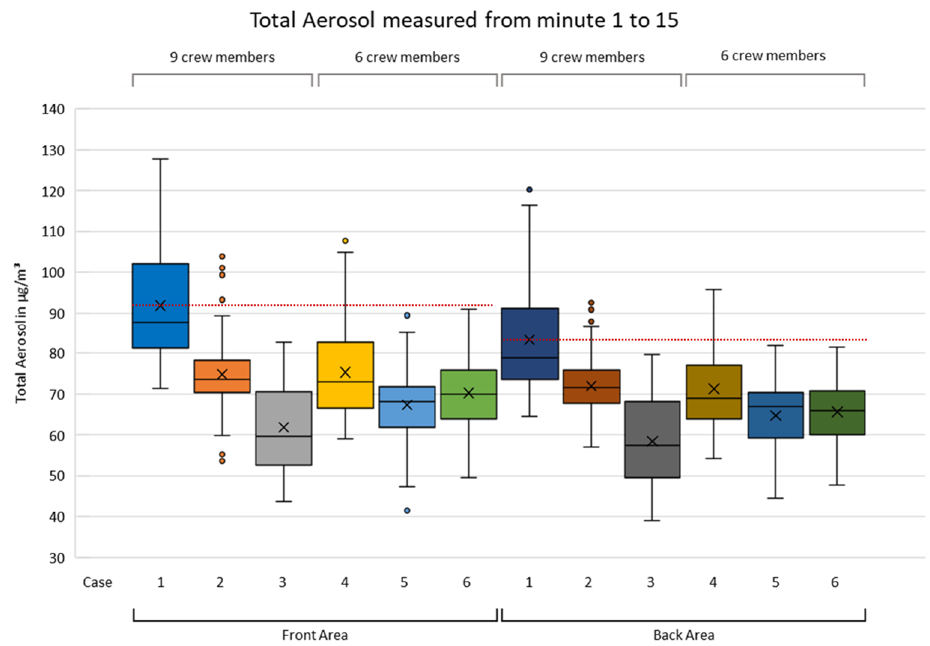
Figure 6. Total aerosol burden measured from minute 1 to 15.